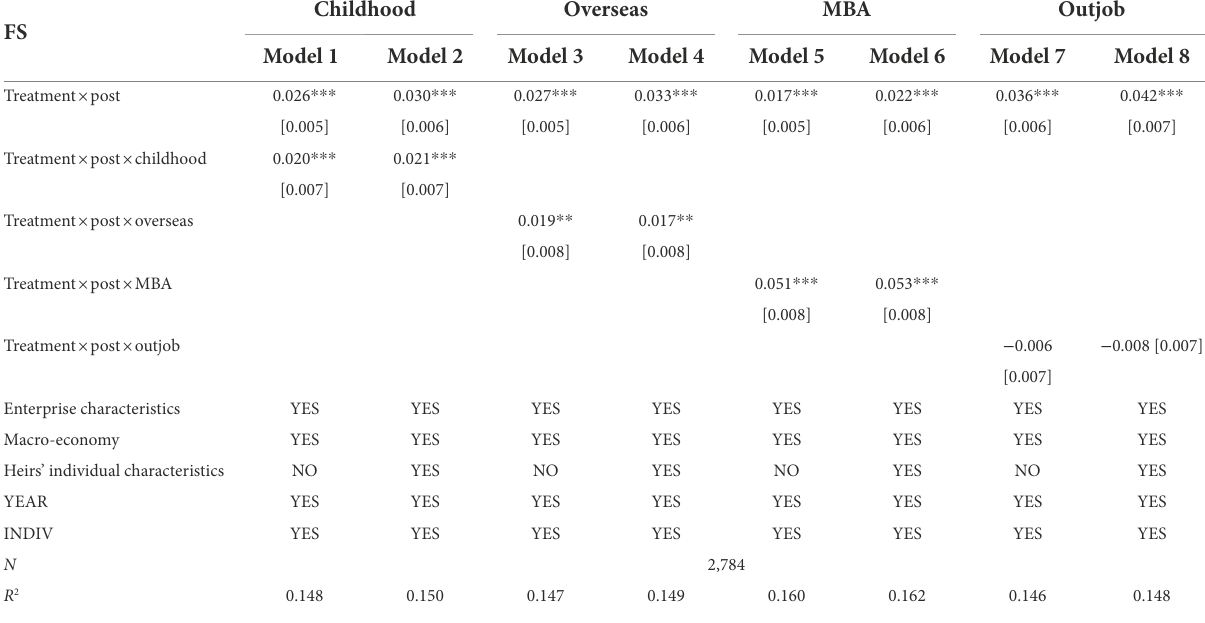
TABLE 9 The moderating effect of heirs’ growing experiences.